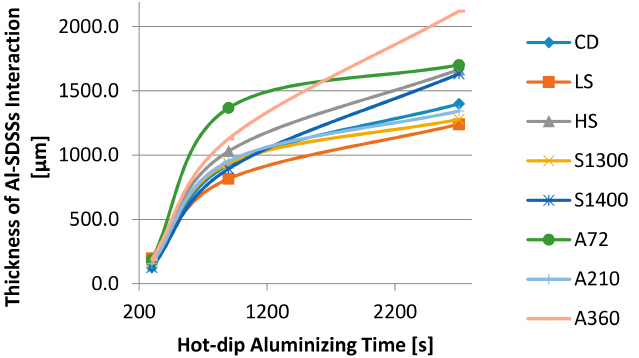
Figure 14. Combination of the thickness of the steel substrate eroded by liquid aluminum and the thickness of ferrite-rich surficial layers resulting by the aluminum